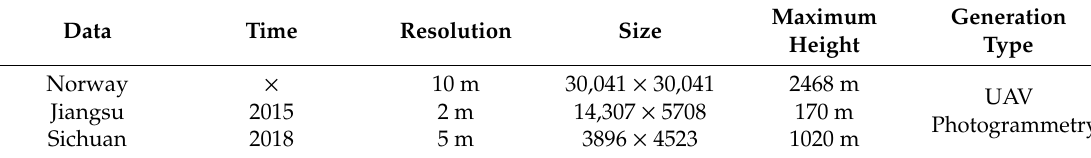
Table 1. Data parameters.